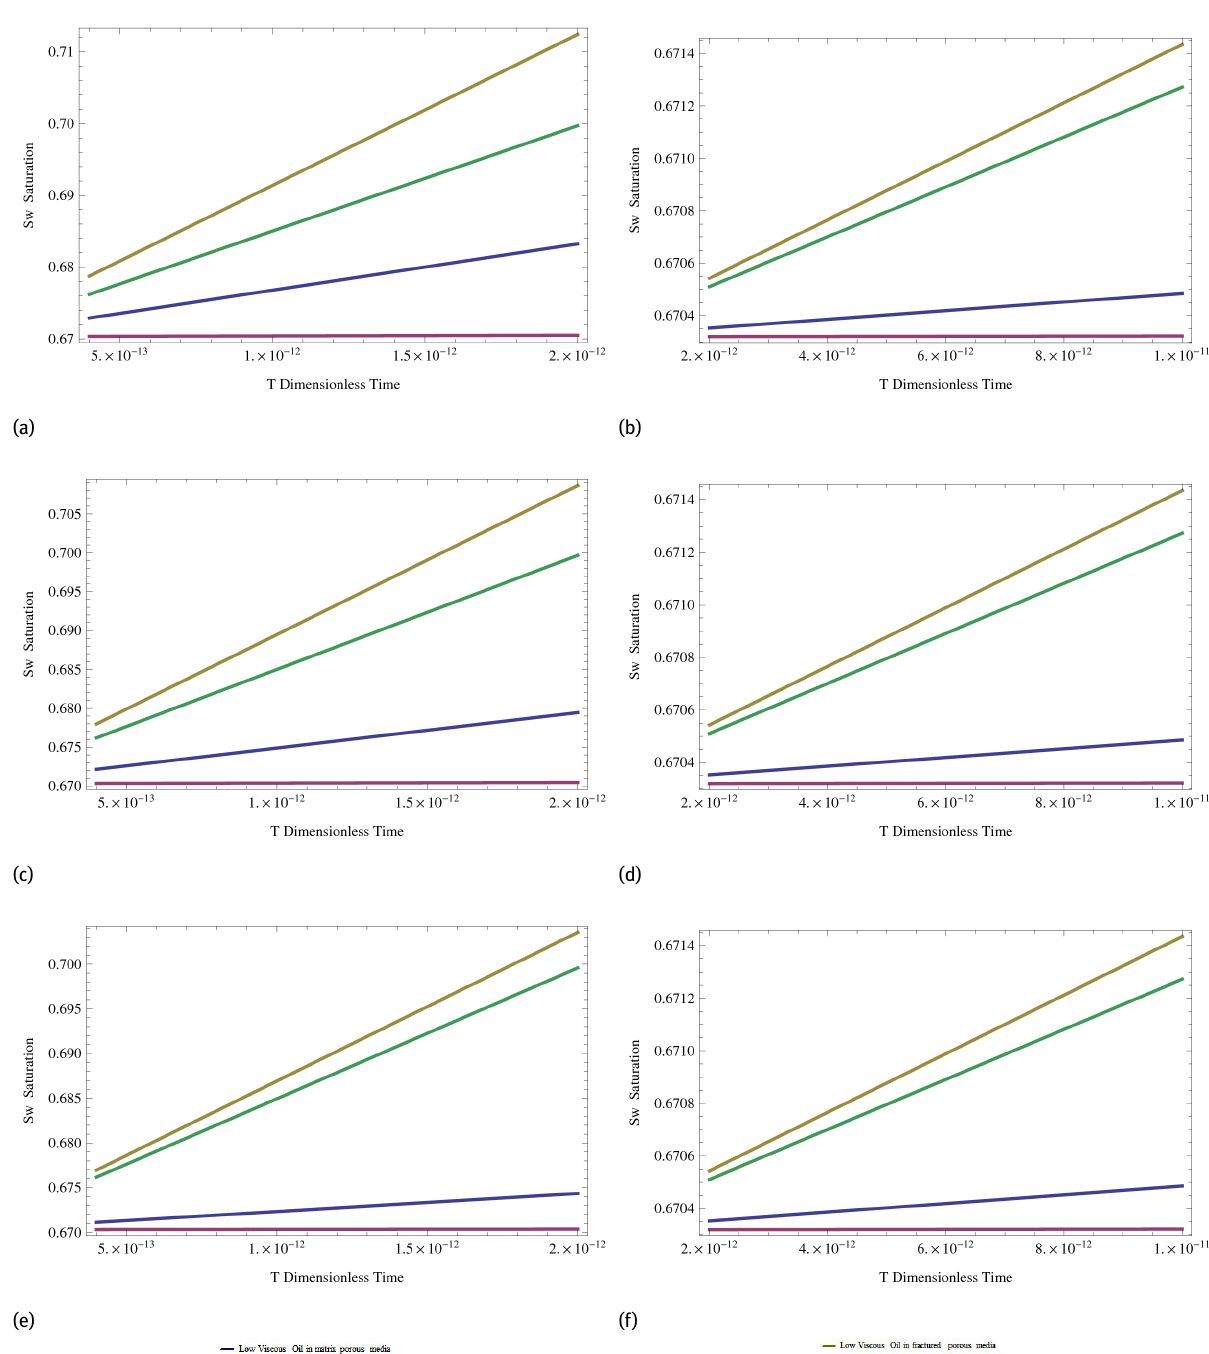
Fig. 3: Satuartion rate for Fine Sand (a) with magnetic field effect (b) without magnetic field effect,Satuartion rate for Volcanic Sand (c) with magnetic field effect (d) without magnetic field effect,Satuartion rate for Glass beads (e) with magnetic field effect (f) without magnetic field